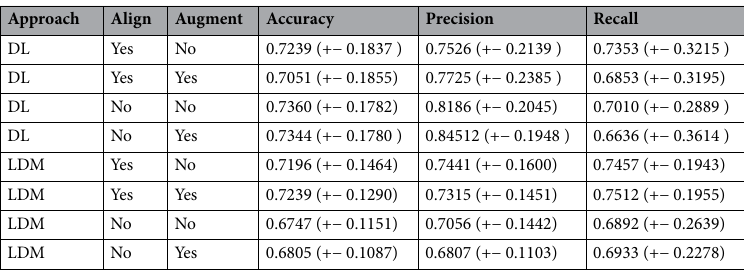
Table 1. Classification performance comparison.